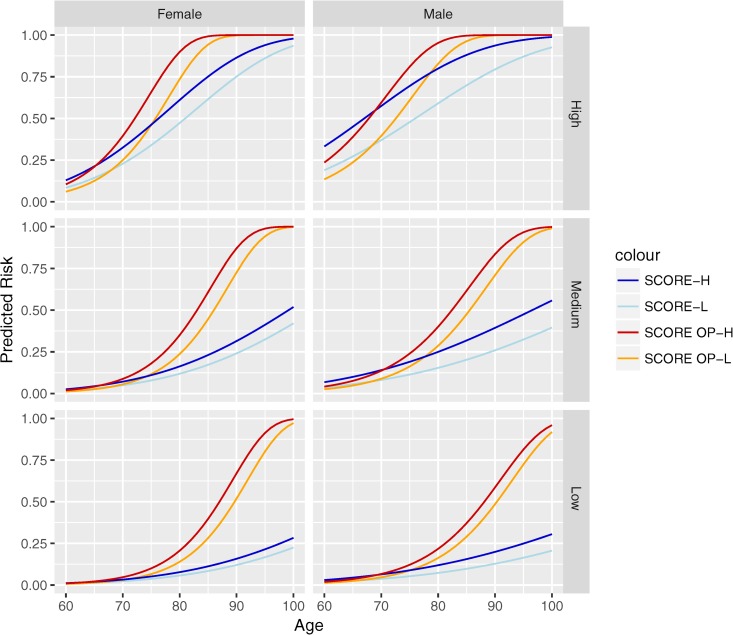
We compared SCORE-L, SCORE-H, SCORE OP-H and SCORE OP-L predicted 10-year risks for six risk profiles; high-, medium- and low-risk for females and males.The high-risk profile was constructed using data from a hypothetical diabetic, current smoker with a systolic blood pressure of 180 mmHg, total cholesterol level of 8 mmol/l, and HDL cholesterol level of 1 mmol/l. The medium-risk profile was created using mean values for all variables based on the baseline characteristics of Berlin Initiative Study participants (see Table 1). The low-risk profile was constructed using data from a hypothetical non-diabetic, current non-smoker with a systolic blood pressure of 120 mmHg, total cholesterol level of 4 mmol/l, and HDL cholesterol level of 2 mmol/l. The high- and low-risk reference values for systolic blood pressure and total cholesterol were taken from the minimum and maximum values reported in the SCORE chart.